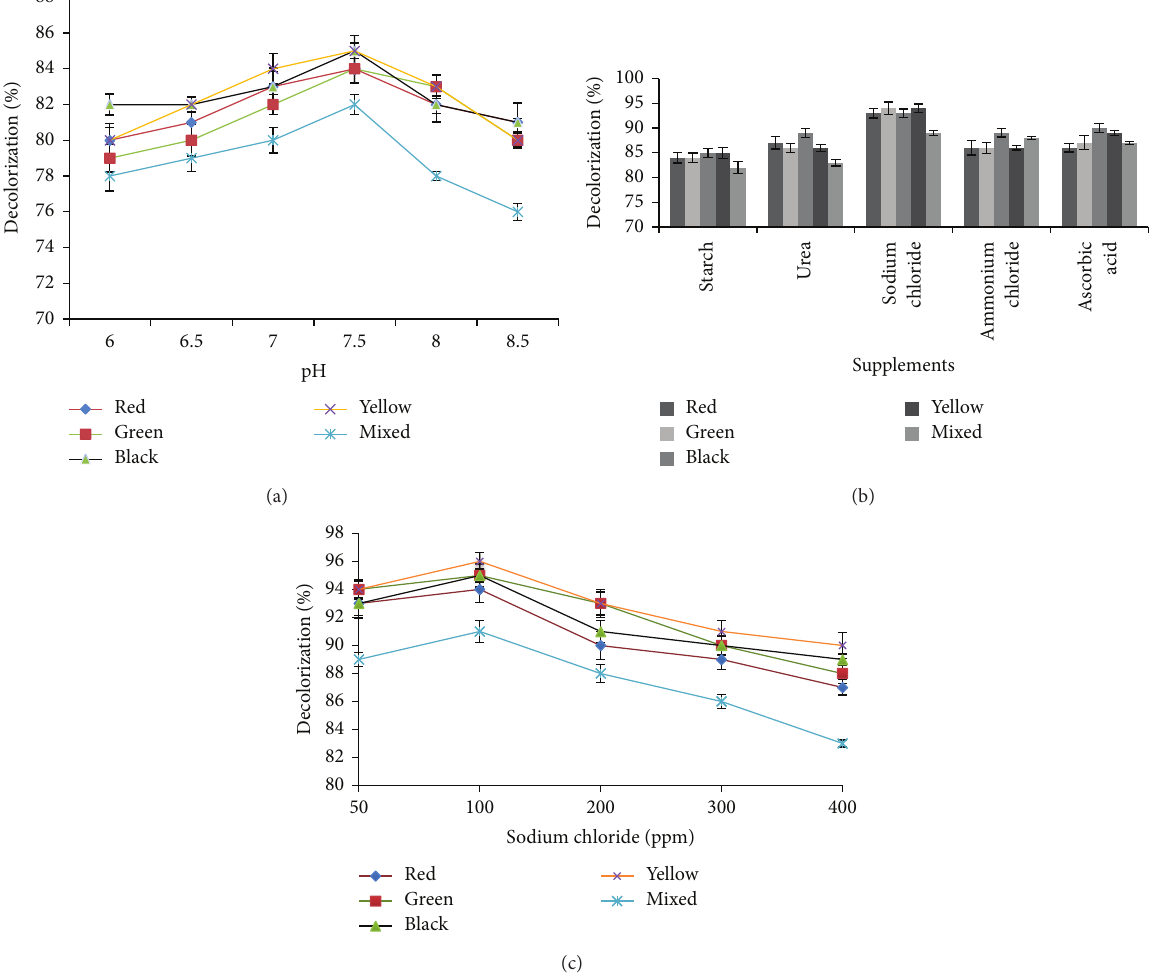
morphologically similar. The isolates 1, 3, 5, 7, 9, and 20 were screened on basis of the ability to degrade the dyes efficiently more than 60%, within 3 days at 50, 100, 150, and 200 ppm of red, green, yellow, and black dyes. These isolates also exhibited ability to degrade mixture of red, green, black, and yellow dyes. The isolates were identified as Bacillus subtilis (Isolate 20), Bacillus cereus (Isolate 3), Bacillus mycoides (Isolate 1), Bacillus sp. (Isolate 5), Pseudomonas sp. (Isolate 9), and Micrococcus sp. (Isolate 7) by standard physiological, morphological, and biochemical tests using the protocol set in Bergey’s Manual of Determinative Bacteriology